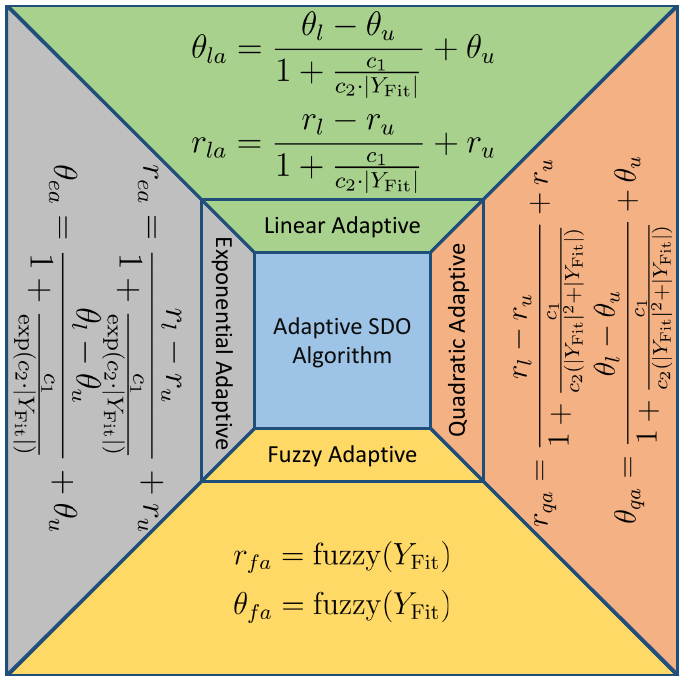
Figure 5. Adaptive versions of the SDO